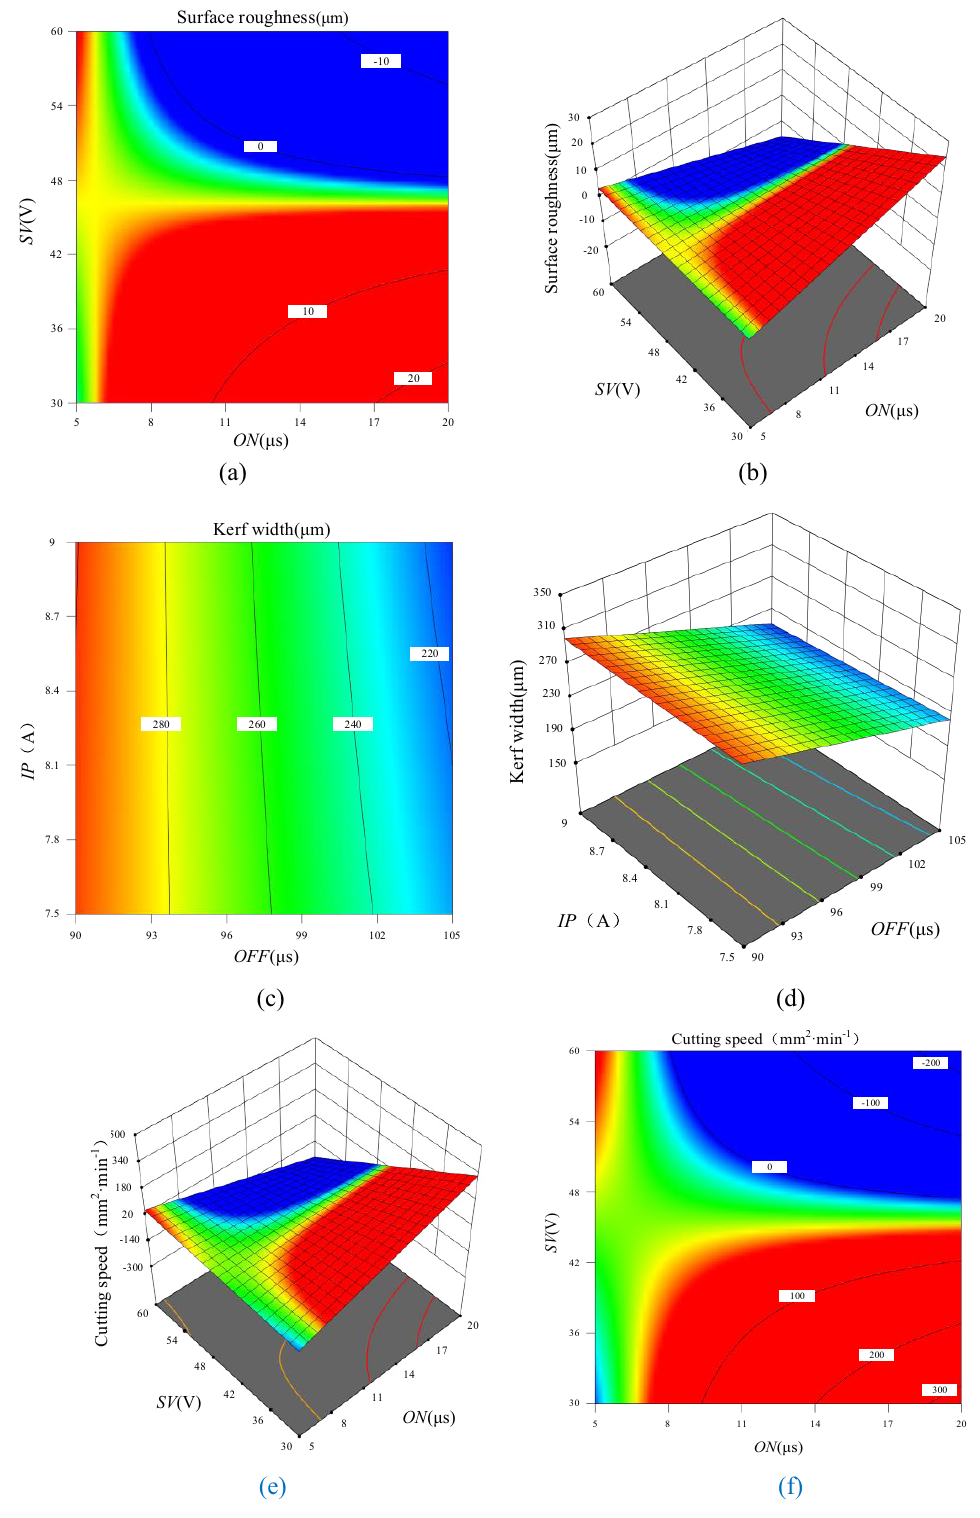
Figure 7: Response surface of surface roughness, kerf width, and cutting speed to electrical parameters: ( a ) surface roughness and ON, SV; ( b ) surface roughness and ON, SV; ( c ) kerf width and IP, OFF; ( d ) kerf width and IP, OFF; ( e ) cutting speed and ON, SV; and ( f ) cutting speed and ON,